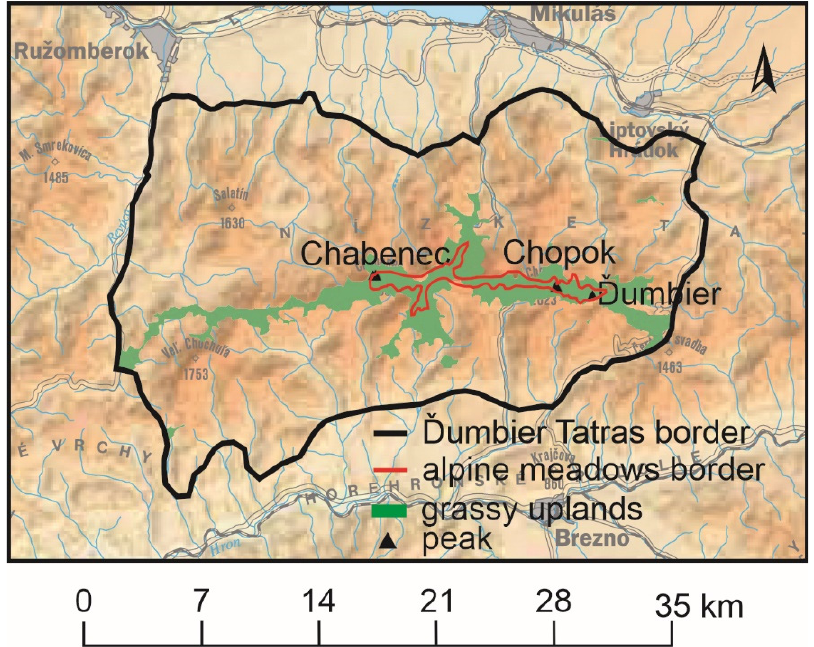
Figure 12. Comparison of the expansion of natural alpine meadows at the turn of the century, when the chamois completely disappeared from the landscape of the Ď umbier Tatras, with the current area of balds created by anthropogenic activities. (Compiled based on: [47]; CORINE Land Cover (Copernicus, 2018).